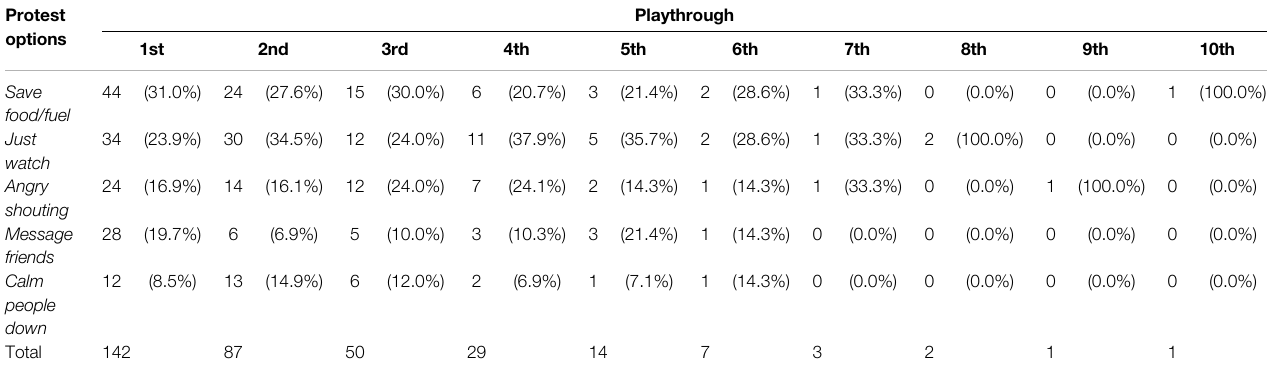
TABLE 6 | Protest choices by